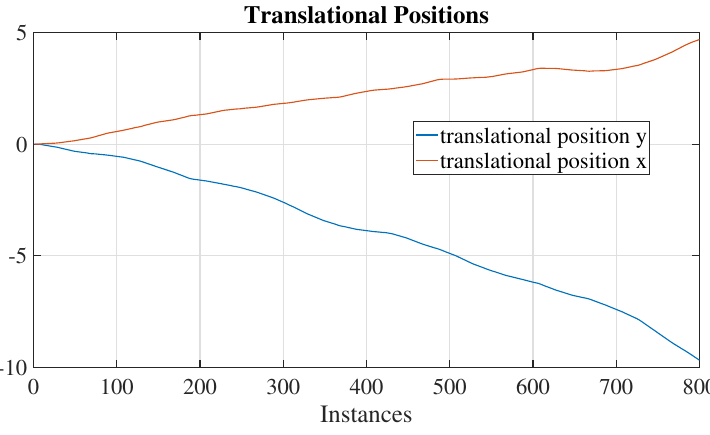
Figure 9. Translational positions x , y .